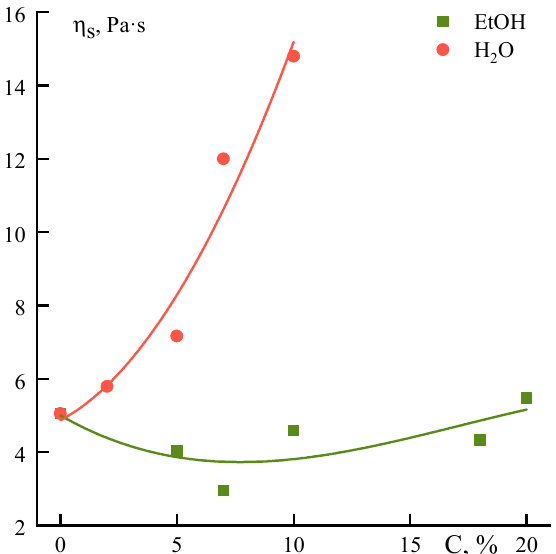
Figure 12. Dependence of viscosity values at the spurt beginning on the content of water and ethanol introduced into the solution.